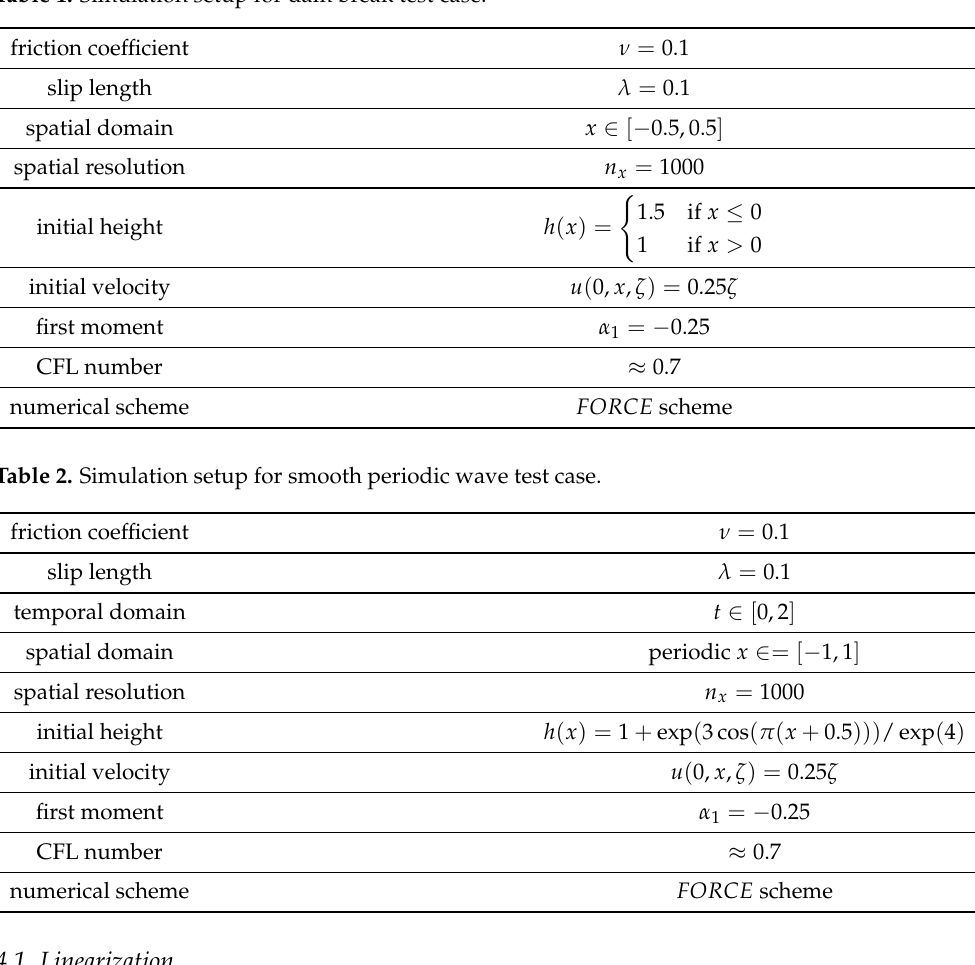
Table 1. Simulation setup for dam break test case.